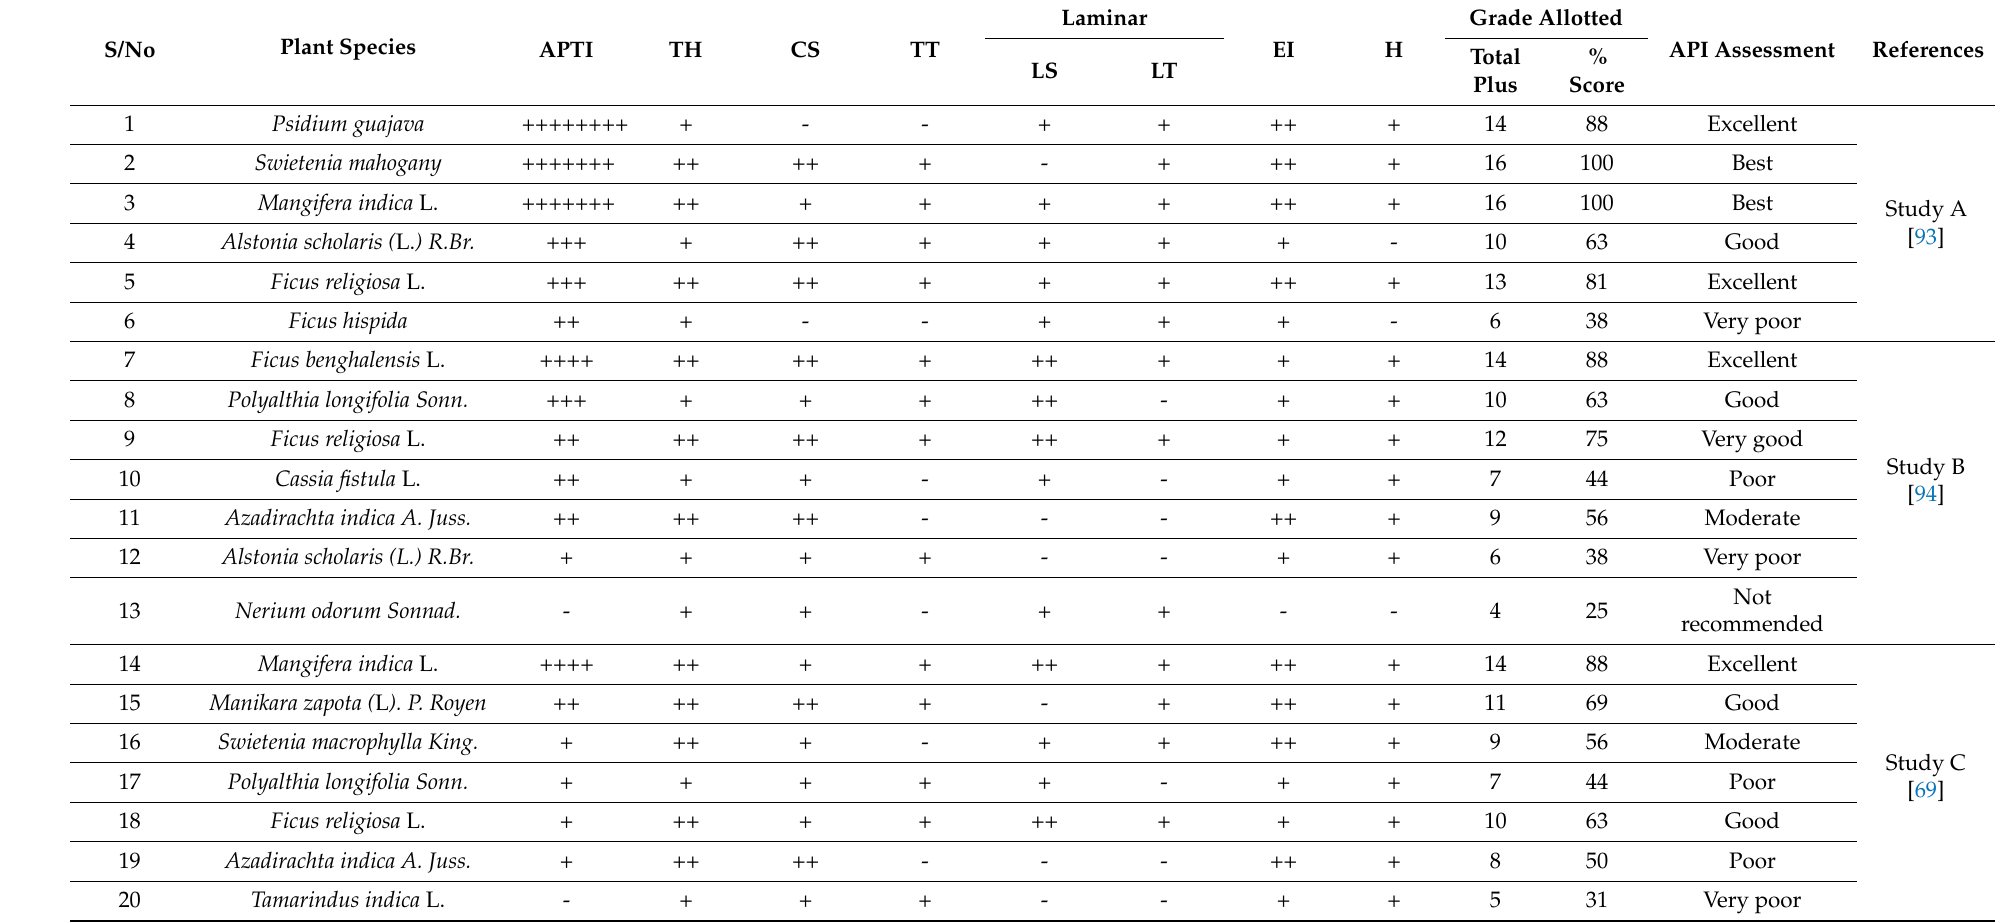
Table 5. Evaluation of plant species based on APTI and some biological and socio-economic